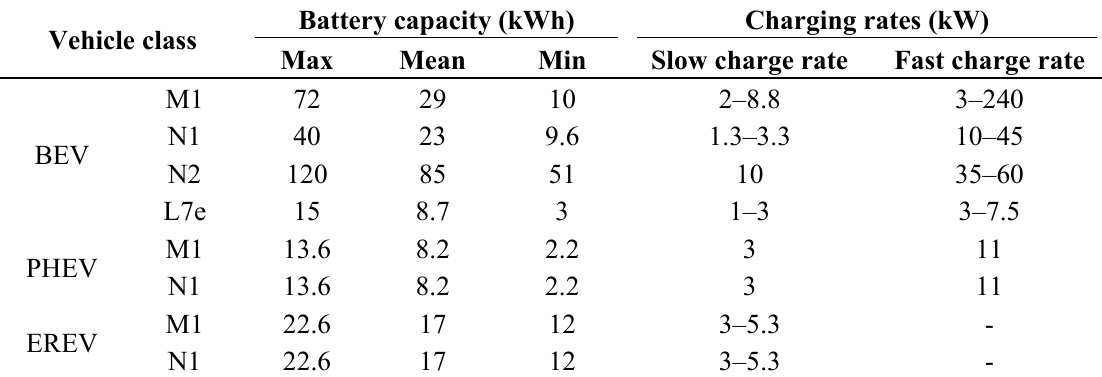
Table 1. EV battery specifications